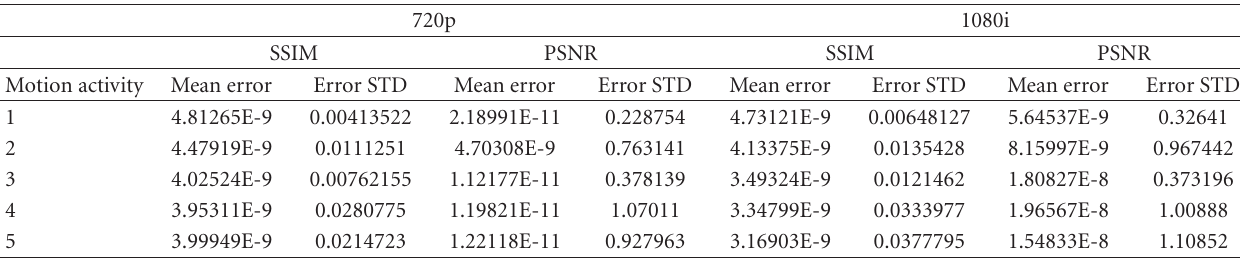
Table 2: Mean errors and standard deviations of model for Qm A